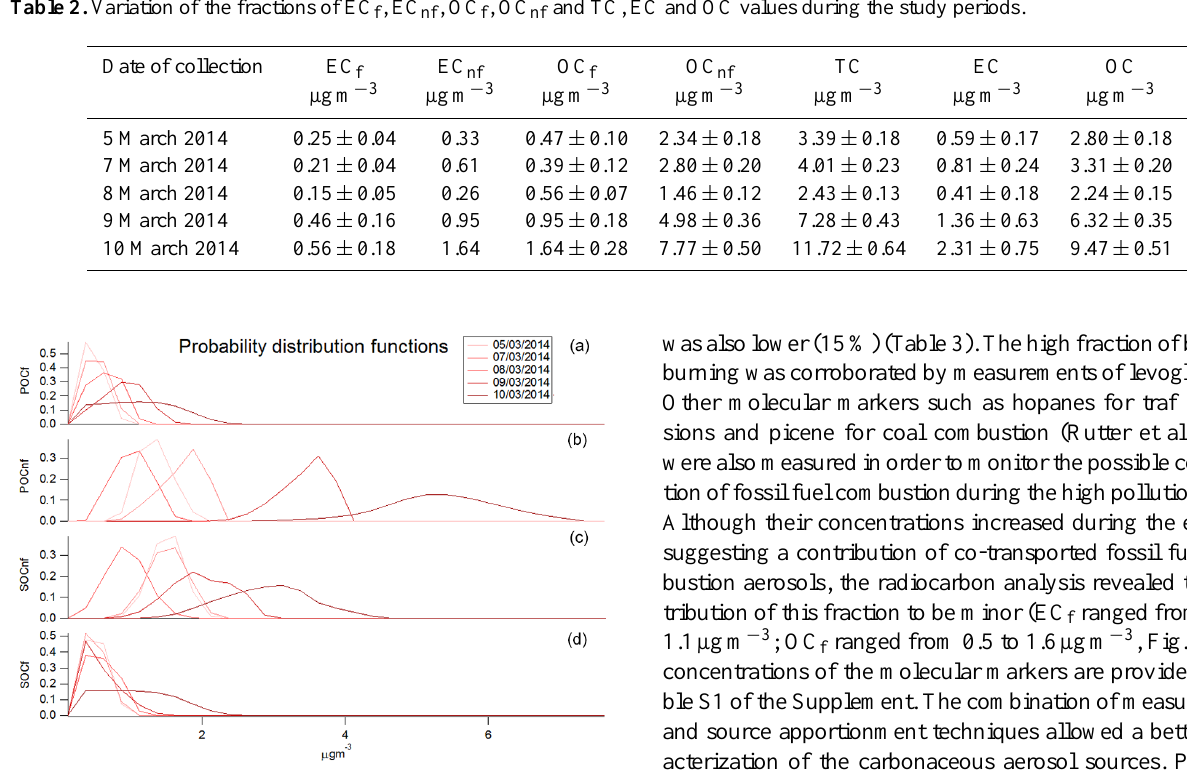
tween 67–86 %. OC nf was estimated to be ∼ 65 % primary, while the primary fraction of the OC f in Preila was estimated to be ∼ 9 %. Conversely, when EC f showed a lower